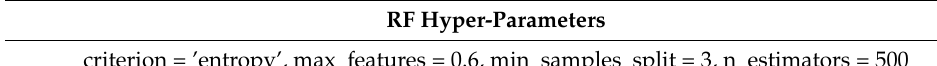
Table 2. F1 scores for each data imputation method.